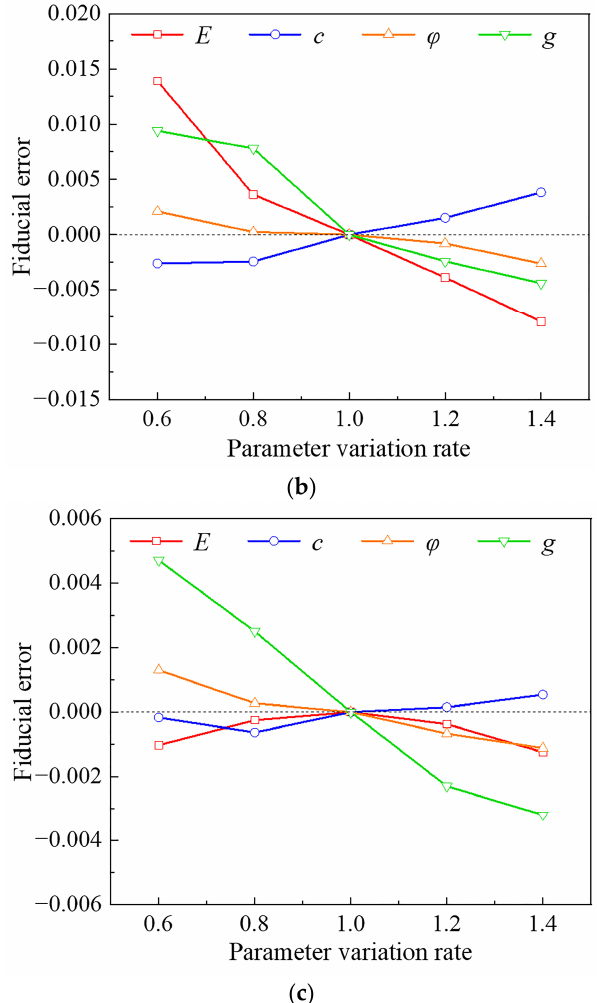
Figure 7. Displacement limit value error curve. ( a ) L1; ( b ) H1; ( c ) H2.